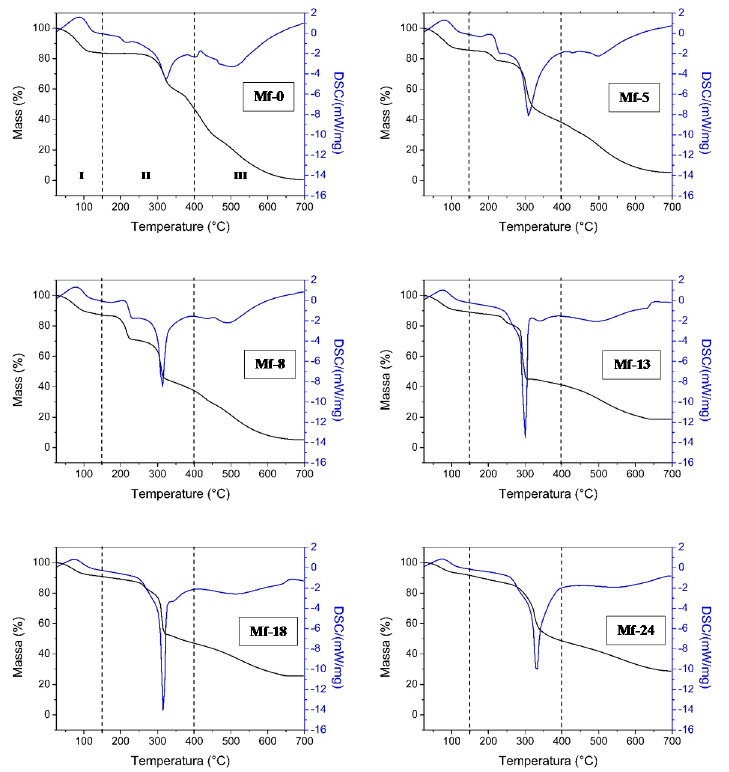
Figure 4. TGA-DSC plots of pure and hybrid polyvinylpyrrolidone (PVP) microfibre coatings. Table 3. Thermogravimetric data from TGA-DSC plots in Figure 4.